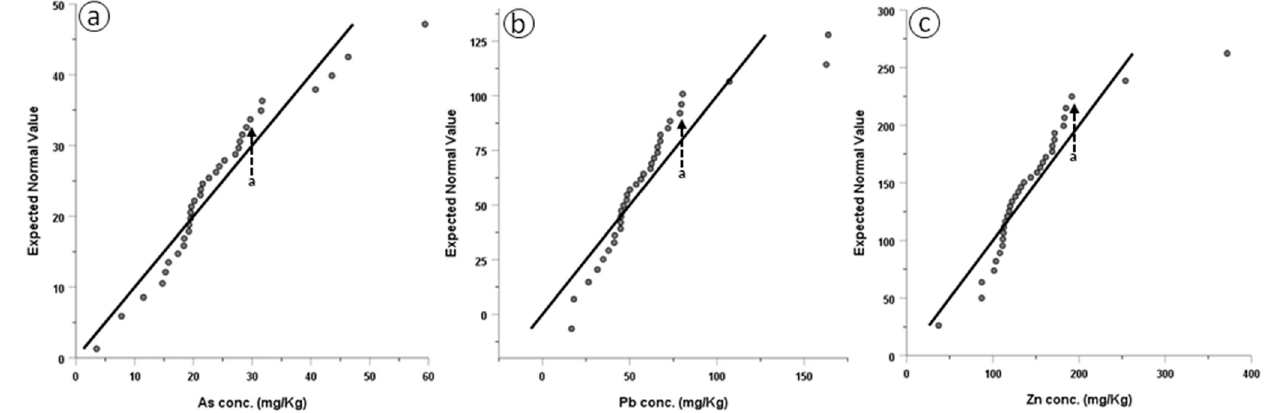
Figure 5. Normal Q–Q plots for As, Pb, and Zn (arrow a indicates inflection point).